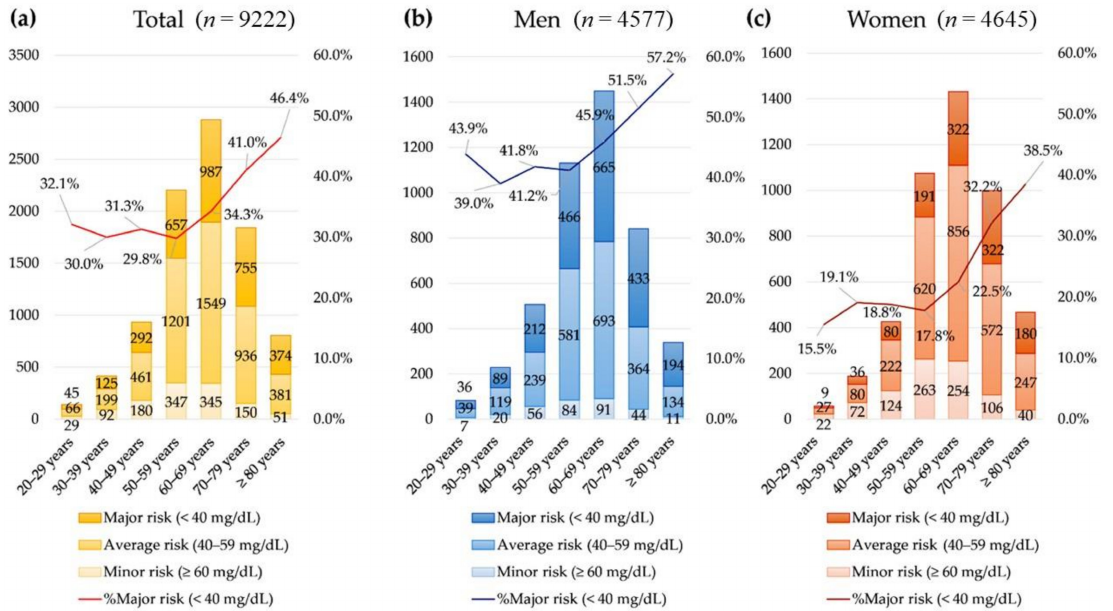
Figure 1. The prevalence of hypercholesterolemia (high total cholesterol ≥ 240 mg/dL) ( a ) in the total population, ( b ) in men, and ( c ) in women.